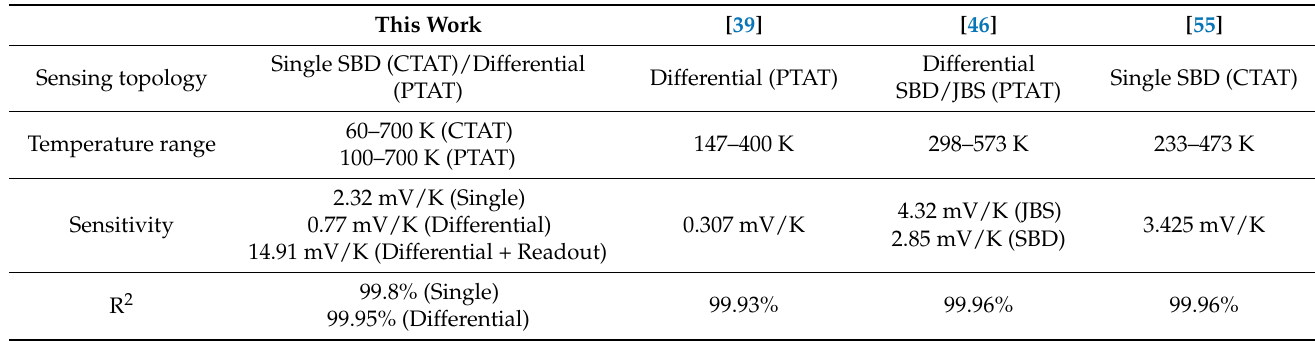
Table 3. Sensor system performance